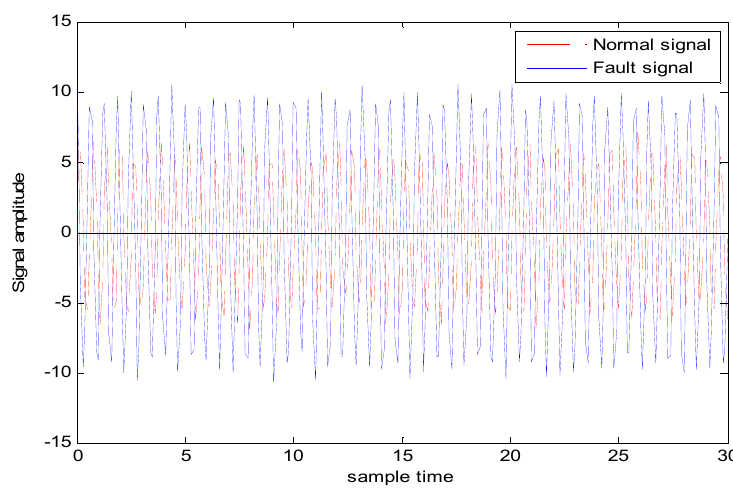
Figure 12. Normal and fault signals with different amplitudes and the same frequency and.